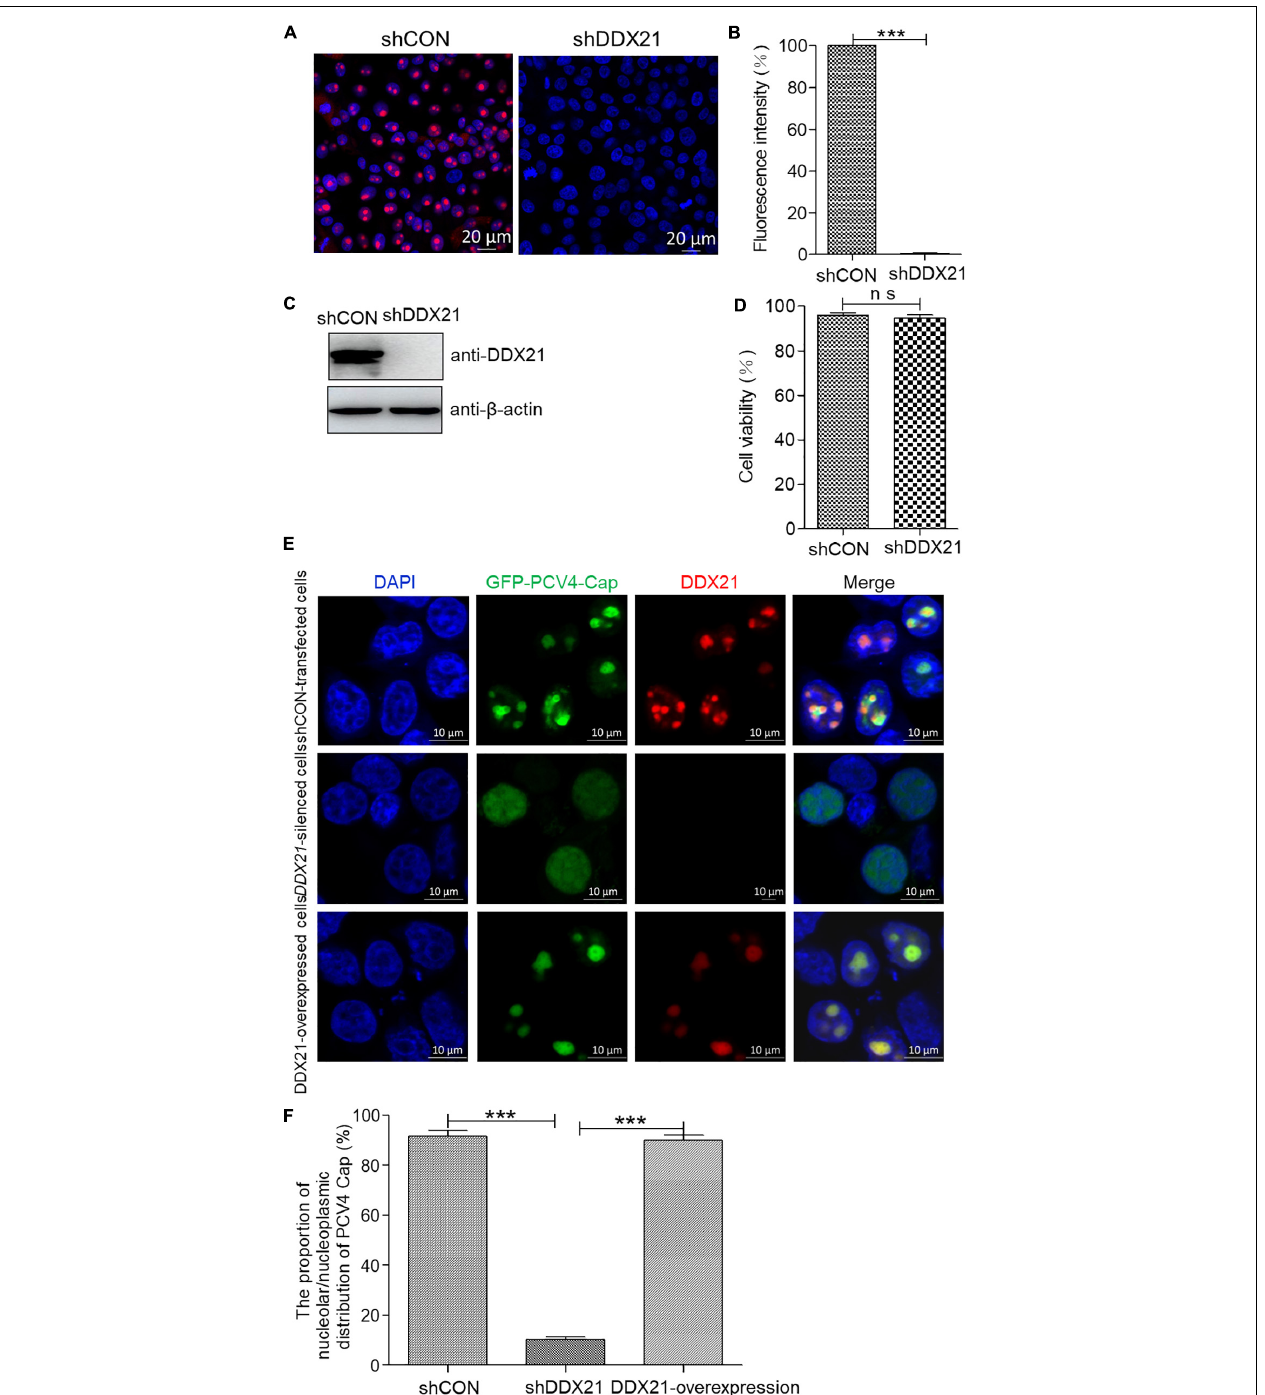
FIGURE 5 | DDX21 knockdown abrogated the nucleolar localization of PCV4 Cap. (A) Immunofluorescence analysis of DDX21 protein in shCON-transfected and DDX21 -silenced PK-15 cells. The cells were incubated with the DDX21 antibody followed by the Alexa Fluor-546 conjugated donkey anti-rabbit IgG (red) secondary antibody. Nuclei were stained with DAPI (blue) and then observed under a confocal microscope. Scale bar, 20 µ m. (B) The fluorescence intensity of DDX21 was analyzed using ImageJ software in shCON- and DDX21 -silenced PK-15 cells. (C) The knockdown efficiency of DDX21 in shCON-transfected and DDX21 -silenced PK-15 cells. The cell lysates were subjected to immunoblotting using the indicated antibodies. (D) The viability of PK-15 cells stably expressing a short hairpin RNA (shDDX21) was analyzed with a cell counting kit-8 (CCK-8) assay. (E) DDX21 -knocked down and shCON-transfected and DDX21-overexpressed PK-15 cells were, respectively, transfected with GFP-PCV4-Cap for 24 h, and the cells were fixed and incubated with the DDX21 antibody and then subjected to confocal microscopic observation. Nuclei were stained with DAPI. Scale bar, 10 µ m. (F) The fluorescence intensity of PCV4 Cap in the nucleolar and nucleoplasmic compartments was analyzed using ImageJ software. Data are presented as means ± SD of three independent experiments. ns, not significant; *** p < 0.001.